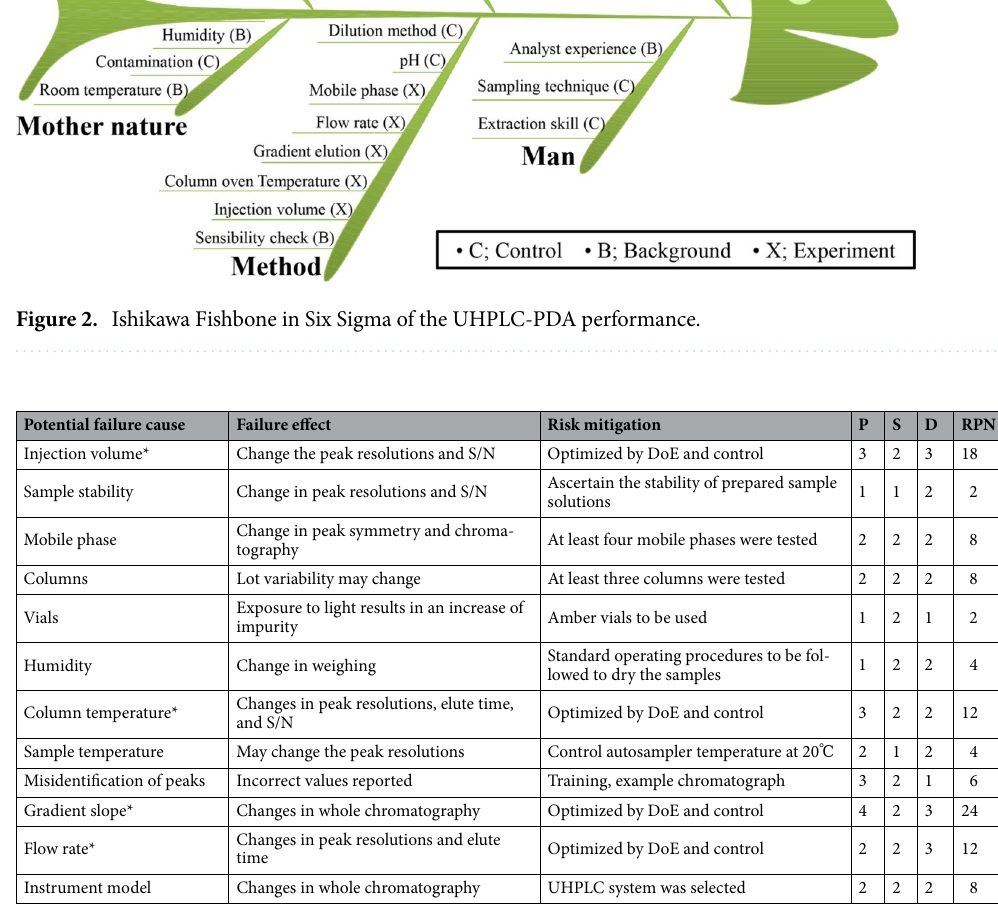
Table 2. Risk assessment and control strategy for AQbD-enabled development UHPLC-PDA method for Genkwa Flos. S/N signal to noise, DoE design of experiments, P probability, S severity, D detectability.